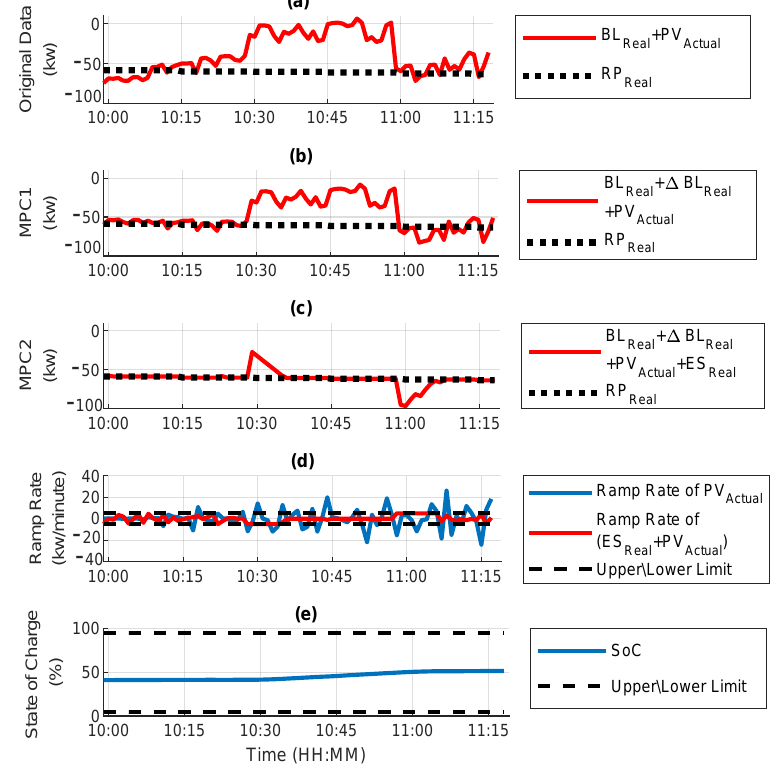
Figure 15. Scenario 2—algorithm performance for real power ( a ) original data, ( b ) MPC1 simulation result, ( c ) MPC2 simulation results, ( d ) ramp rate constraint, and ( e ) energy storage SoC constraint.